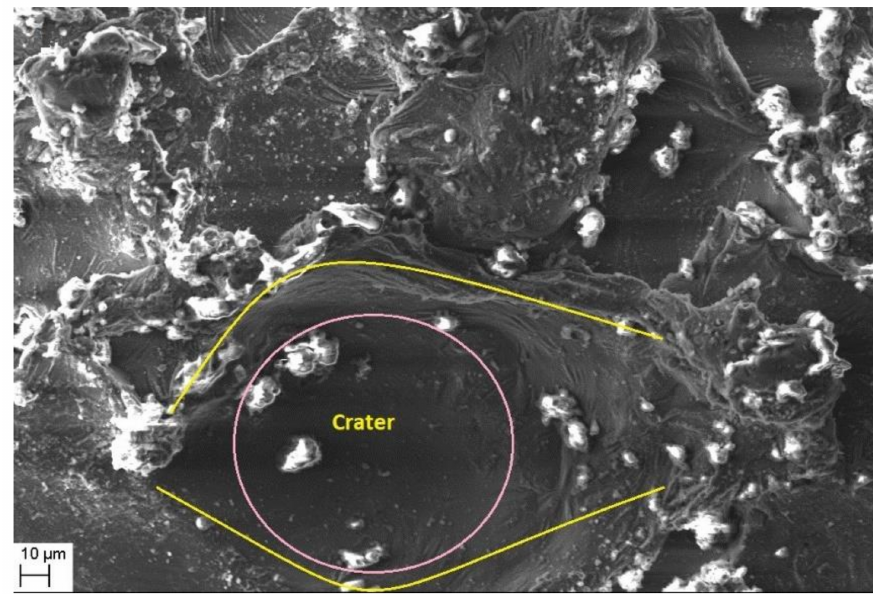
Figure 9. The crater